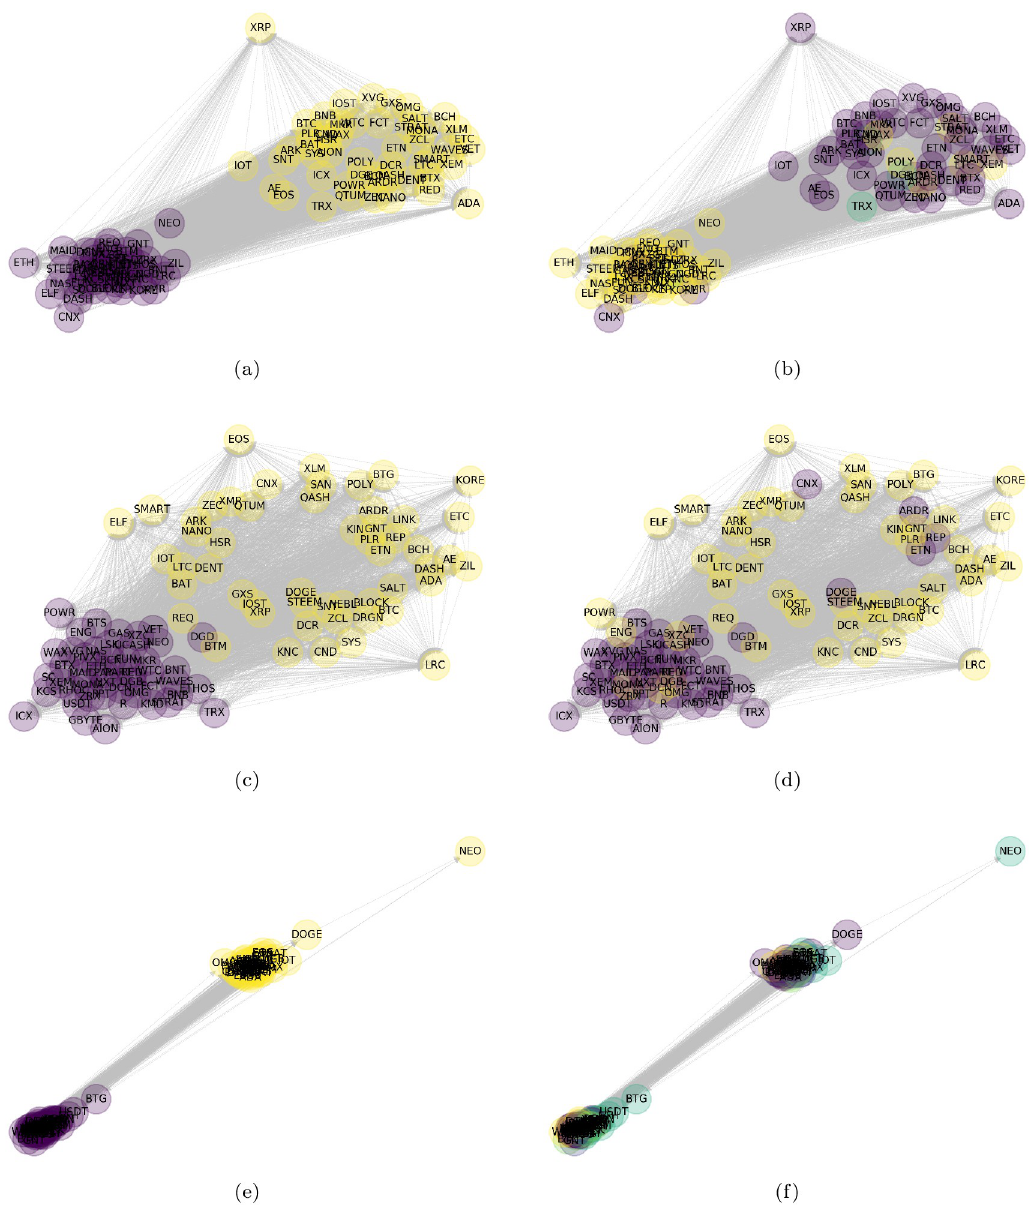
Fig 5. Predictor-reponse clusters vs. modularity clusters. Comparision of the cluster formed by the heuristic variable selection rule of Eq 12 (left figures) and the cluster formed by the modularity approach of Eq 13 (right figures). From top to bottom the cases Δ t = 1, m = 3((a) and (b)), Δ t = 1, m = 2 ((c) and (d)), Δ t = 0, m = 4 ((e) and (f)). The node names represent the symbol of the associated cryptocurrency as listed on the annexed table in the appendix (see S1